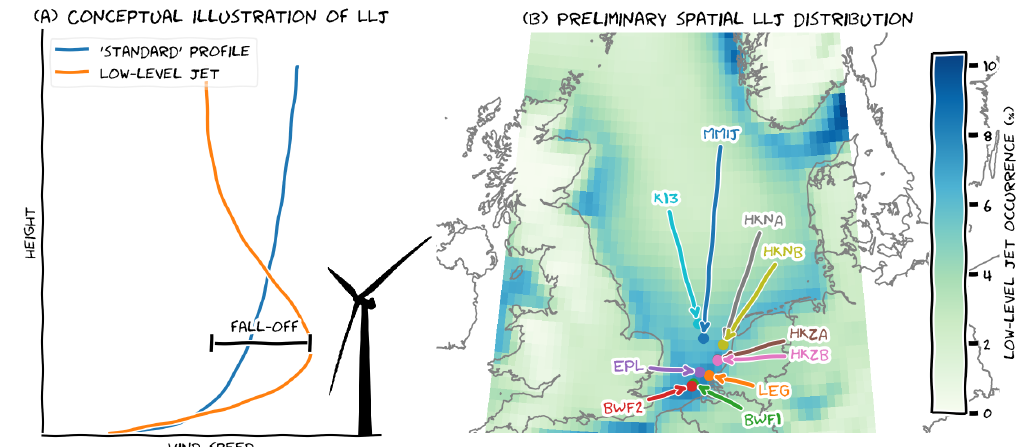
Figure 1. (a) Example low-level jet profile as compared to the “standard” logarithmic wind profile. (b) Preliminary spatial distribution of annual low-level jet occurrence based on 10 years of ERA5 data up to 500m. Overlaid are the location of the 10 measurement platforms used in this analysis: Met Mast IJmuiden (MMIJ), Hollandse Kust Noord A (HKNA) and B (HKNB), Hollandse Kust Zuid A (HKZA) and B (HKZB), Lichteiland Goeree (LEG), Borssele Wind Farm Lots 1 (BWF1) and 2 (BWF2), Europlatform (EPL), and K13. Colour coding is consistent across all